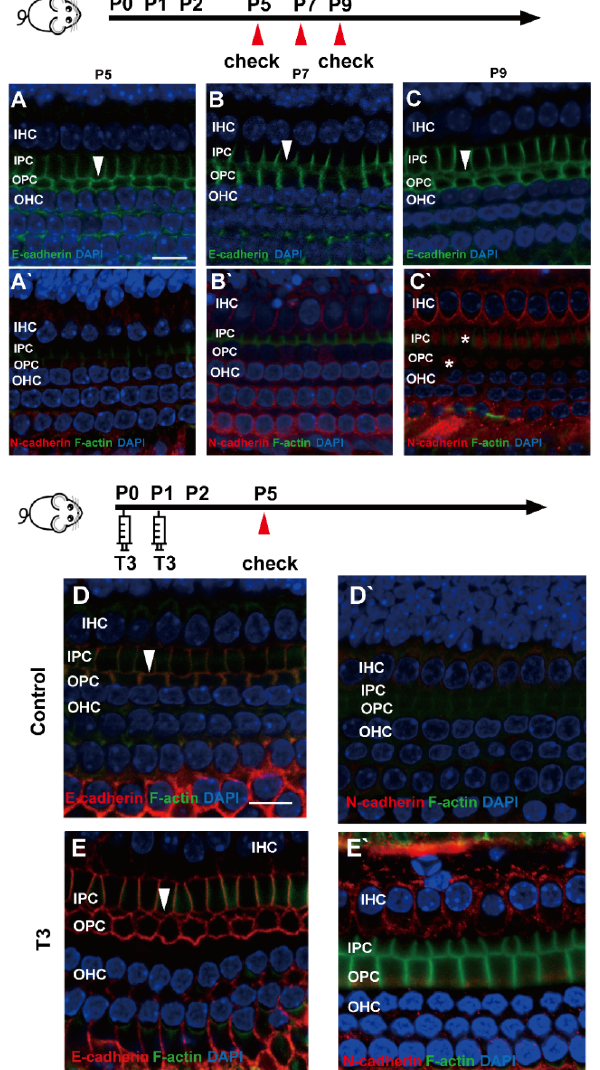
Figure 4. E-cadherin and N-cadherin do not change significantly during opening of the TC. ( A – C ) Stain- ing of E-cadherin (green) in the hair cells of the P5, P7 and P9 groups, respectively. Nuclei were counterstained with DAPI (blue). ( A ’– C ’) Staining of N-cadherin (red) in the hair cell nuclei (blue) in